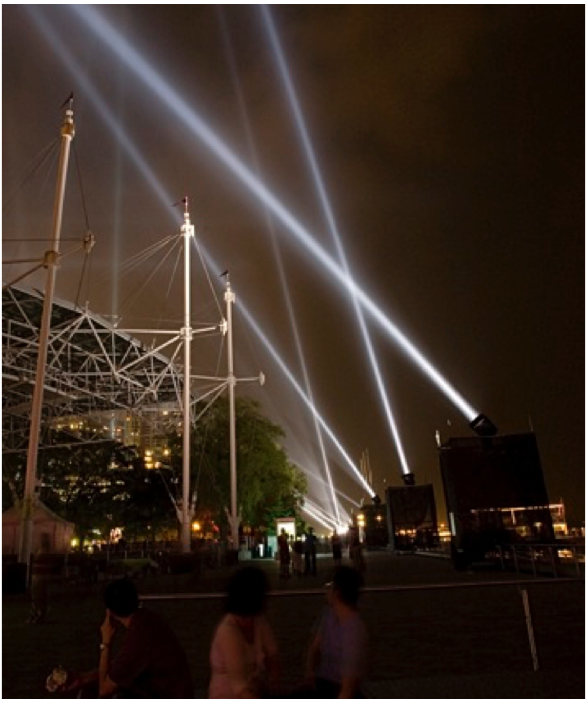
Figure 4 | Rafael Lozano-Hemmer, Pulse Front , 2008. Photo by Antimodular Research.